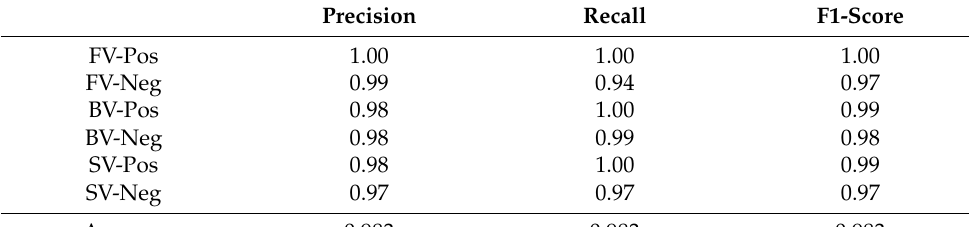
Table 14. Precision, recall, and F1-score for the second experiment on the PETA dataset.